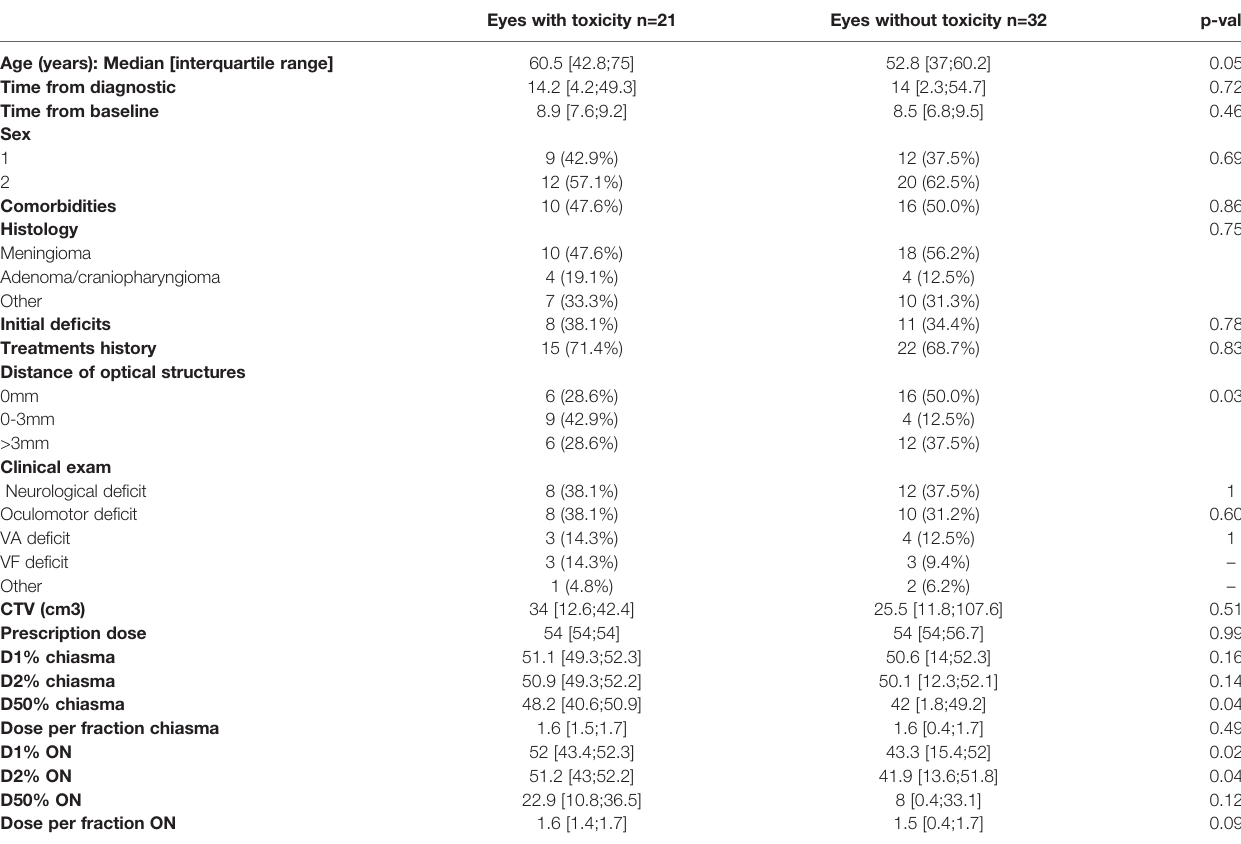
TABLE 6 | Comparison of patients who experienced VEP toxicity to those who remained normal, analyses for VEP 60 ’ .